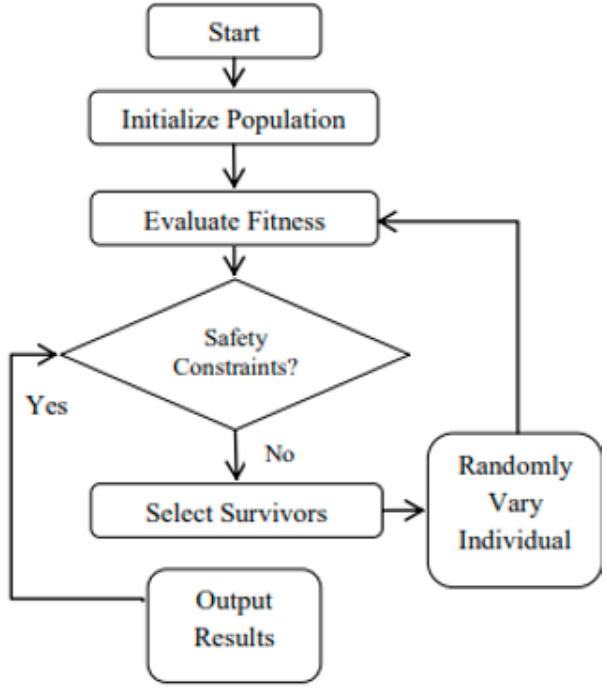
Figure 10. Flow chart for the operation of GA control.